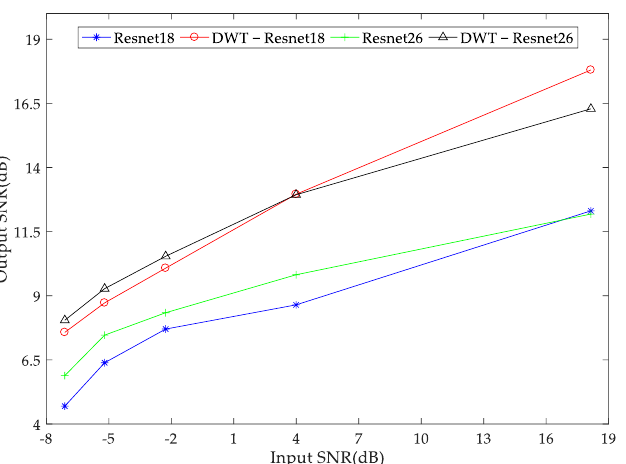
Figure 9. Trends of the best denoising results of DWT − Resnet26 with different SNR real seismic data under different wavelet bases.